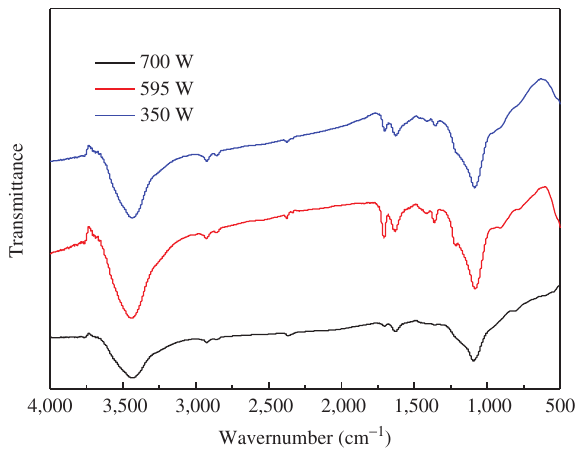
Figure 4: Effect of microwave power on the activation yield of activated carbon.